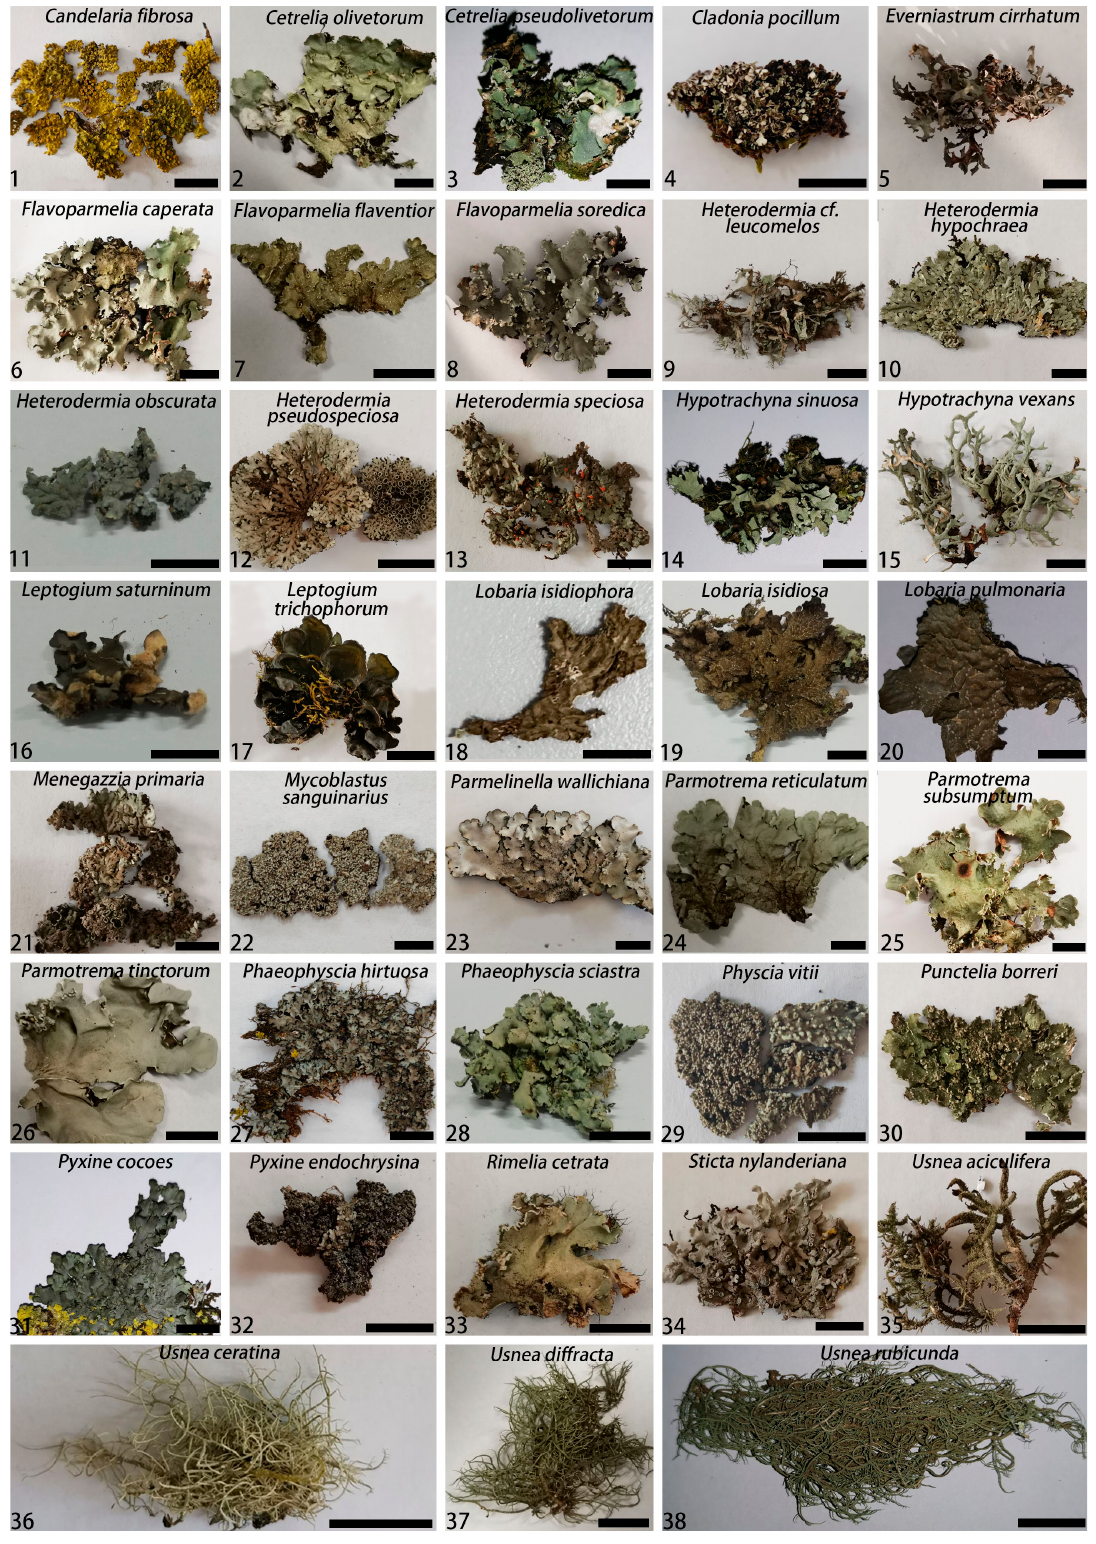
Figure 1. Morphology of 38 lichen samples collected in Yunnan Province in China between 2020 and 2021. During the species identification process, photographs were taken using the dried thallus samples. Bars = 1 cm.